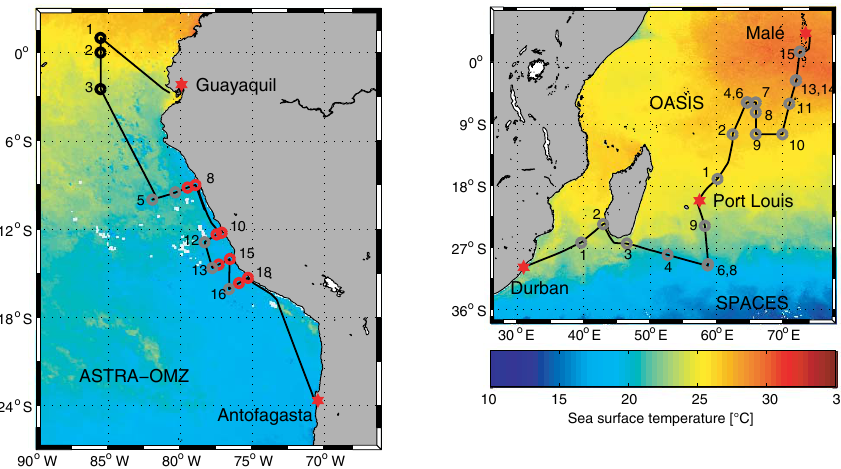
Figure 1. Cruise tracks (black) of ASTRA-OMZ (October 2015, eastern Pacific Ocean) and of SPACES and OASIS (July/August 2014, Indian Ocean) plotted on top of monthly mean sea surface temperature detected by the Moderate Resolution Imaging Spectroradiometer (MODIS) instrument on board the Aqua satellite. Circles indicate CTD stations (grey: SPACES and OASIS as well as open-ocean stations during ASTRA-OMZ; black: equatorial stations during ASTRA-OMZ; red: coastal stations during ASTRA-OMZ). Numbers indicate stations where a CTD depth profile was performed. Stations 6 and 8 (SPACES) as well as stations 4 and 6, and 13 and 14 (OASIS) have almost the same geographical coordinates. If a station number is omitted (SPACES: stations 5 and 7; OASIS: stations 3, 5, and 12; ASTRA-OMZ: stations 4 and 9), no CTD cast was performed.